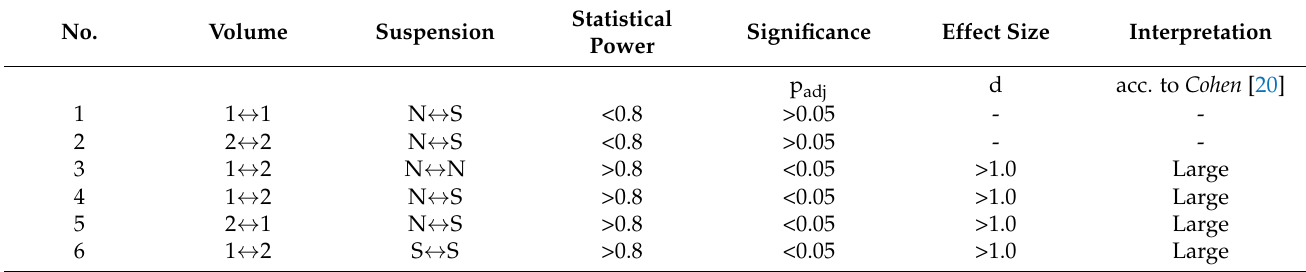
Table 4. Statistical evaluation: influence of tactile impulses on the perception of audible impulses (N: Normal, S: Sport). No. Volume